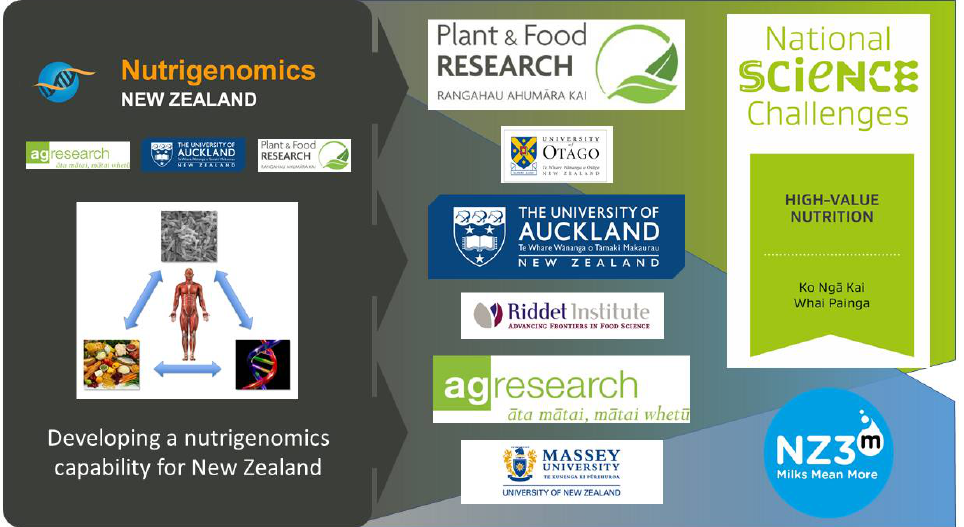
Figure 1. The contribution of the Nutrigenomics New Zealand programme to the NZ research landscape.